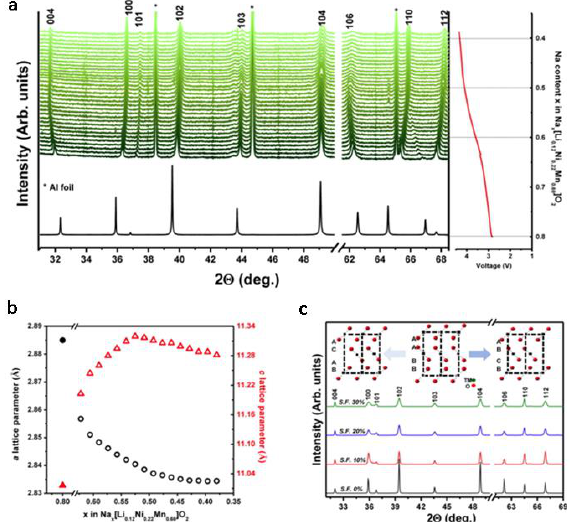
Figure 9. ( a ) In-situ XRD on Na 0.80 [Li 0.12 Ni 0.22 Mn 0.66 ]O 2 during the first charge (Al collector is labelled as “*”) and the corresponding charge curve. ( b ) Evolution of the a and c lattice parameters during the first charge obtained from Rietveld refinement (solid symbols represent a and c values in the pristine state). ( c ) XRD patterns obtained by simulating different amounts of O2-type stacking fault in P2 structure [170]; with permission from ACS.